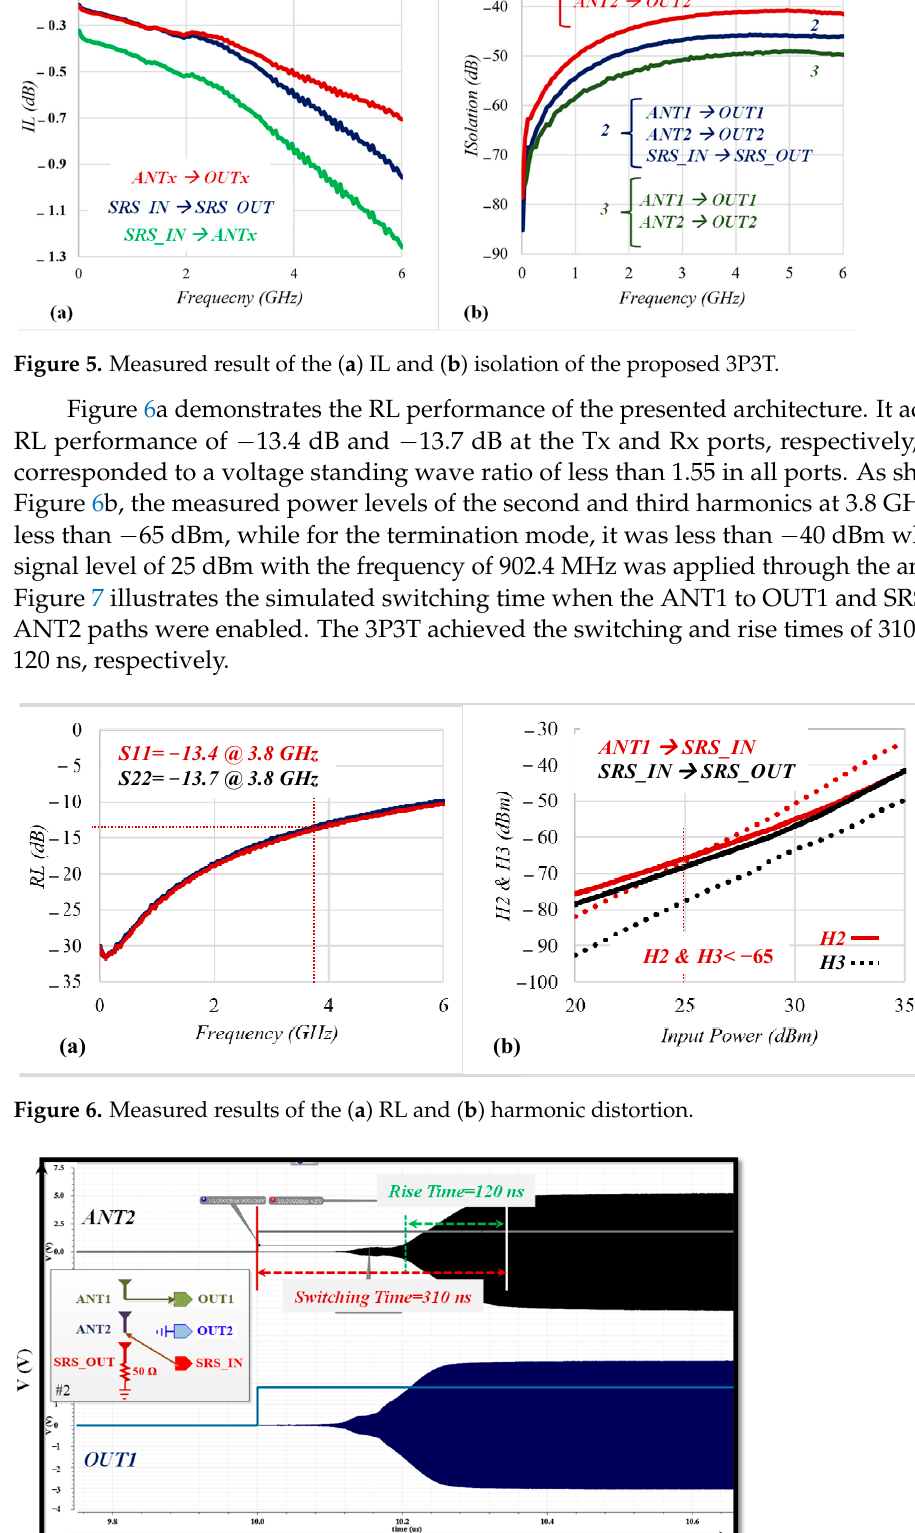
Figure 7. Simulation result of the switching time for switching case of 2.